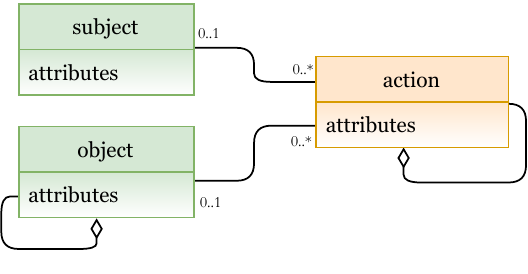
Figure 6. DAC model instance.